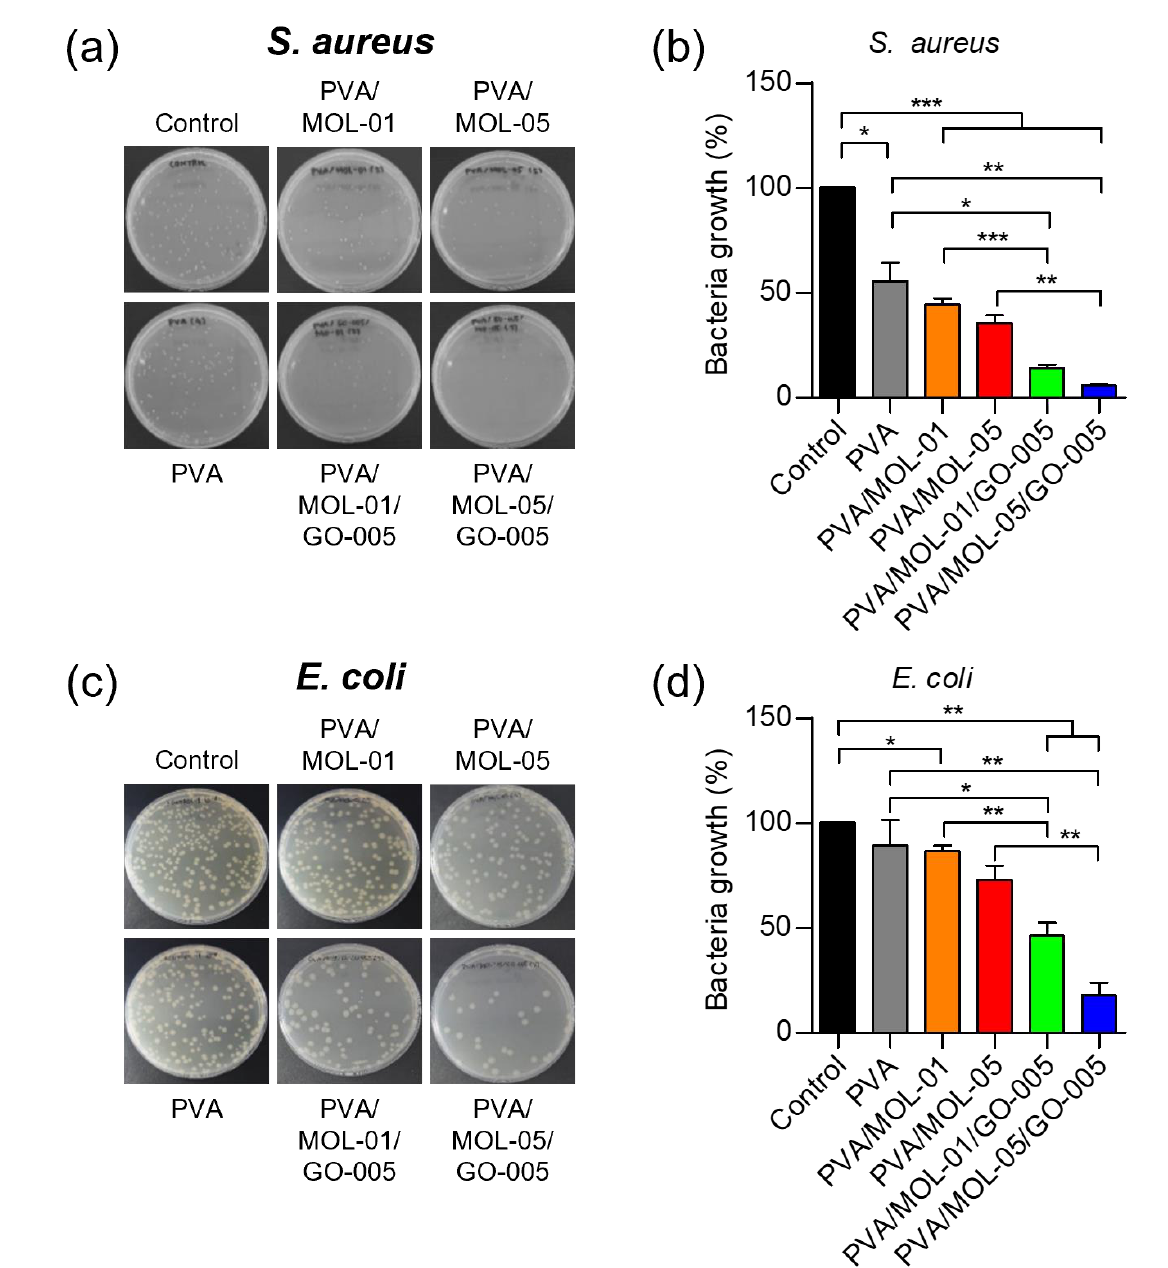
Figure 7. Antibacterial activity of hydrogels towards S. aureus ATCC 6538 and E. coli ATCC 8939 using the TPC method after a 24 h incubation. ( a ) Representative images and ( b ) quantitative analyses of S. aureus colony growth treated with the different hydrogels. ( c ) Representative images and ( d ) quantitative analyses of E. coli colony growth treated with the different hydrogels. Data represents means ± SD from at least three independent experiments. * p < 0.05, ** p < 0.01, *** p < 0.001.